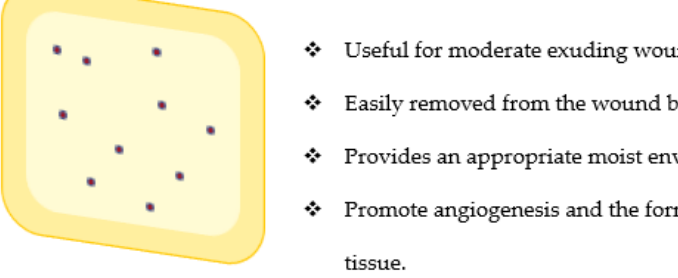
Figure 4. Hydrocolloid wound dressings.